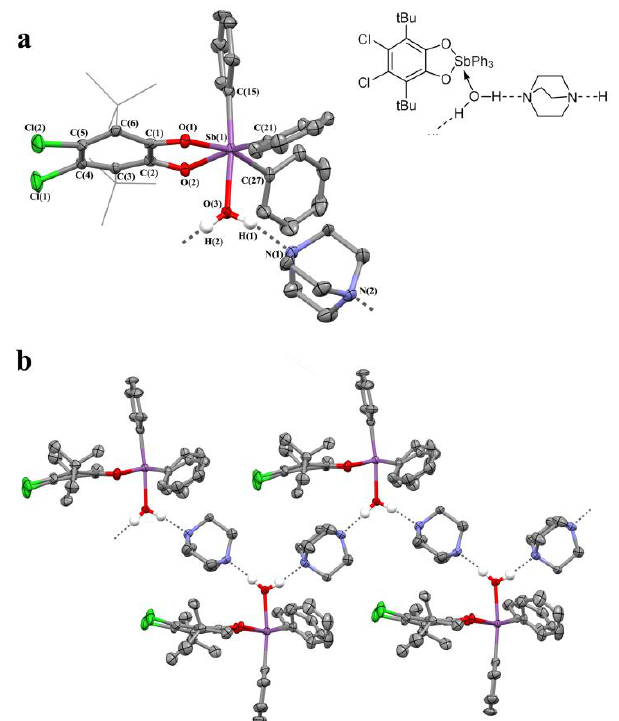
Figure 7. The X-ray structure of 12 : a) the unit (4,5-Cl 2 -3,6-Cat)SbPh 3 ∙H 2 O∙DABCO; b) the 1D chain in crystal of 12 . The hydrogen atoms (except H 2 O) are omitted. The selected bond lengths (Ǻ) and angles (°): Sb(1)-O(1) 2.049(3), Sb(1)-O(2) 2.046(3), Sb(1)-O(3) 2.309(3), Sb(1)-C(15) 2.151(5), Sb(1)-C(21) 2.147(5), Sb(1)-C(27) 2.156(5), O(1)-C(1) 1.329(6), O(2)-C(2) 1.327(5), O(3)-H(1) 0.942(10), O(3)-H(2) 0.945(10), H(1)-N(1) 1.819(10), H(2)-N(2) 1.811(10), O(1)-Sb(1)-O(2) 77.50(12),